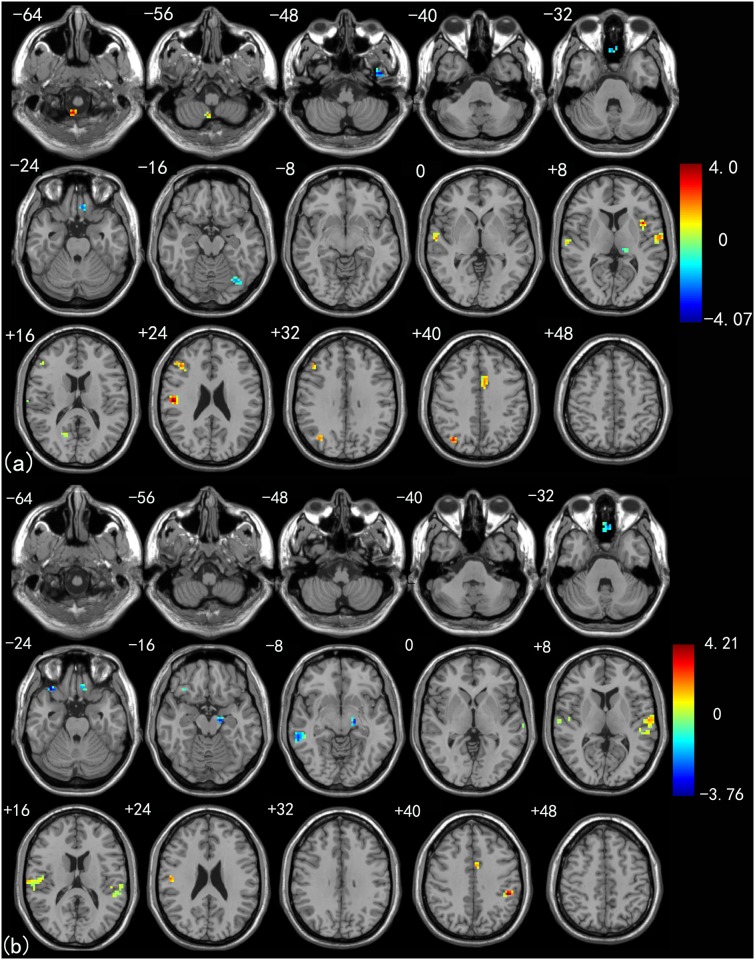
Left (a) and right (b) thalamus connectivity difference maps between LMCI patients and EMCI patients (P < 0.01, 40 voxels, Alphasim corrected).